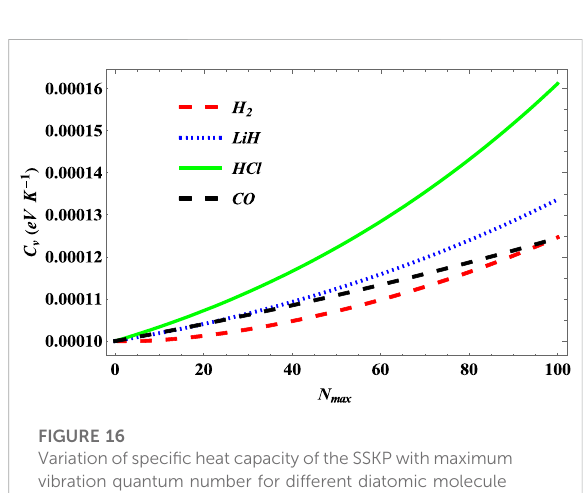
FIGURE 13 Variation of free energy of the SSKP with maximum vibration quantumnumberfordifferentdiatomicmoleculesystemswith n = 2 and l = 1.